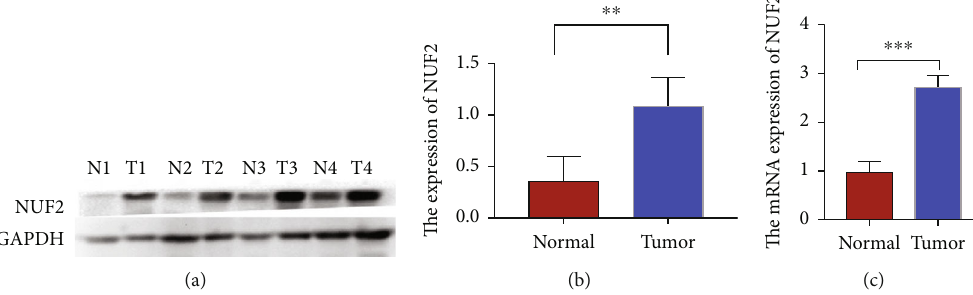
Figure 10: (a and b) Expression of NUF2 in four non-small-cell lung cancer tissues and adjacent normal tissues detected by western blotting. GADPH was used as loading control. ∗ P < 0 : 05 and ∗∗ P < 0 : 01 . (c) The mRNA expression of NUF2 in four non-small-cell lung cancer tissues and adjacent normal tissues detected by RT-PCR. Table 5: Clinical data of four cases of WB